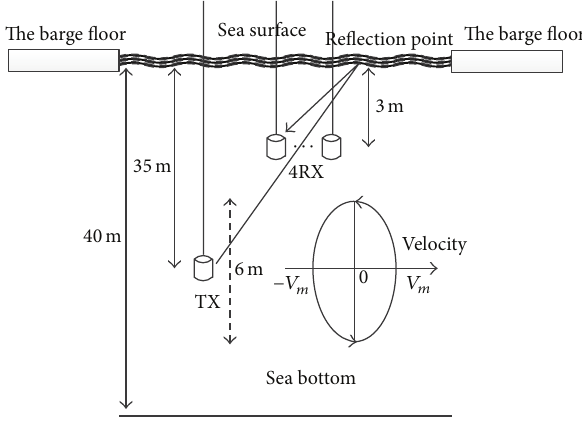
Figure 11: The experiment setting.